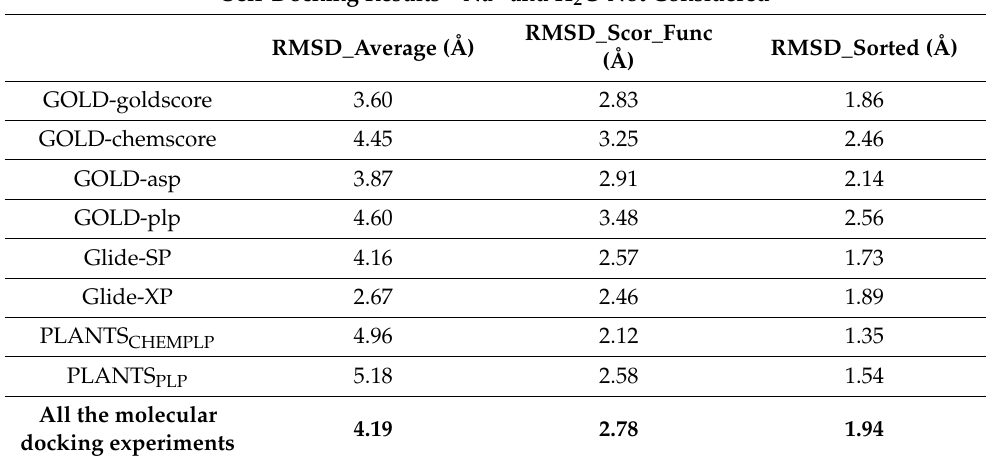
Table 1. Table showing the results of the self-docking calculations executed without considering the sodium